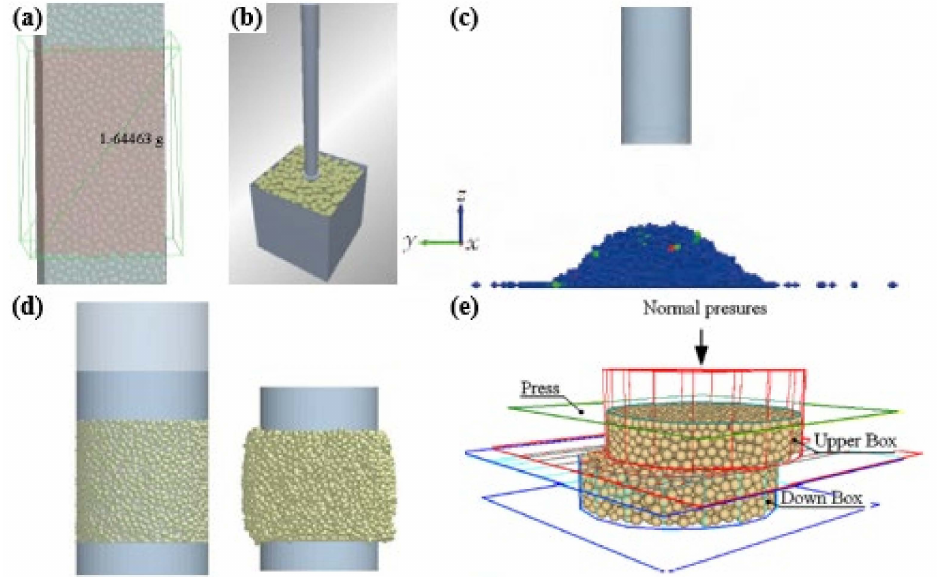
Figure 8. Simulation screenshot of ( a ) bulk density test, ( b ) cone penetration test, ( c ) angle of repose test, ( d ) compression test, and ( e ) shear